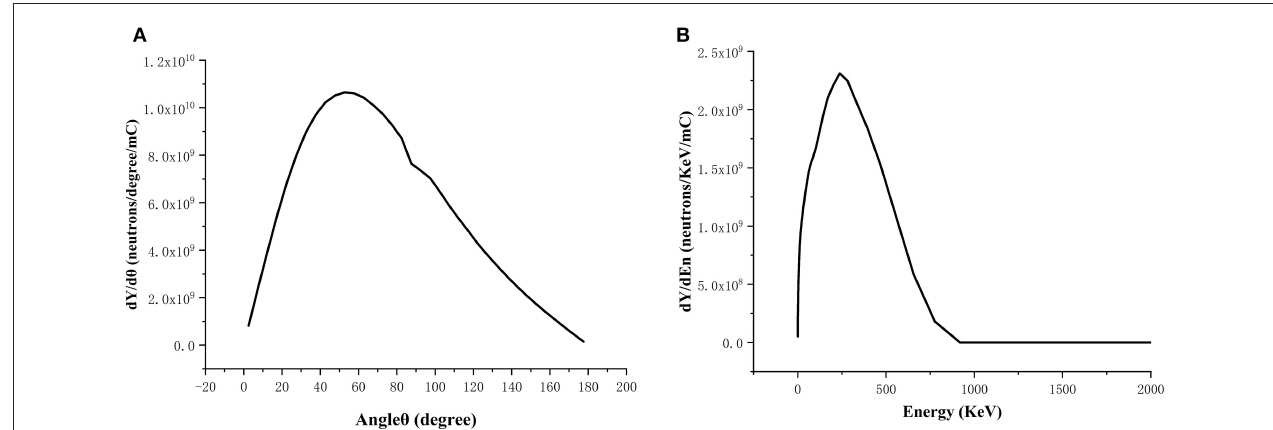
FIGURE 2 | Spectrum (A) and angular distribution (B) of the neutron beam generated from bombarding Li target by 2.5 MeV/30 mA